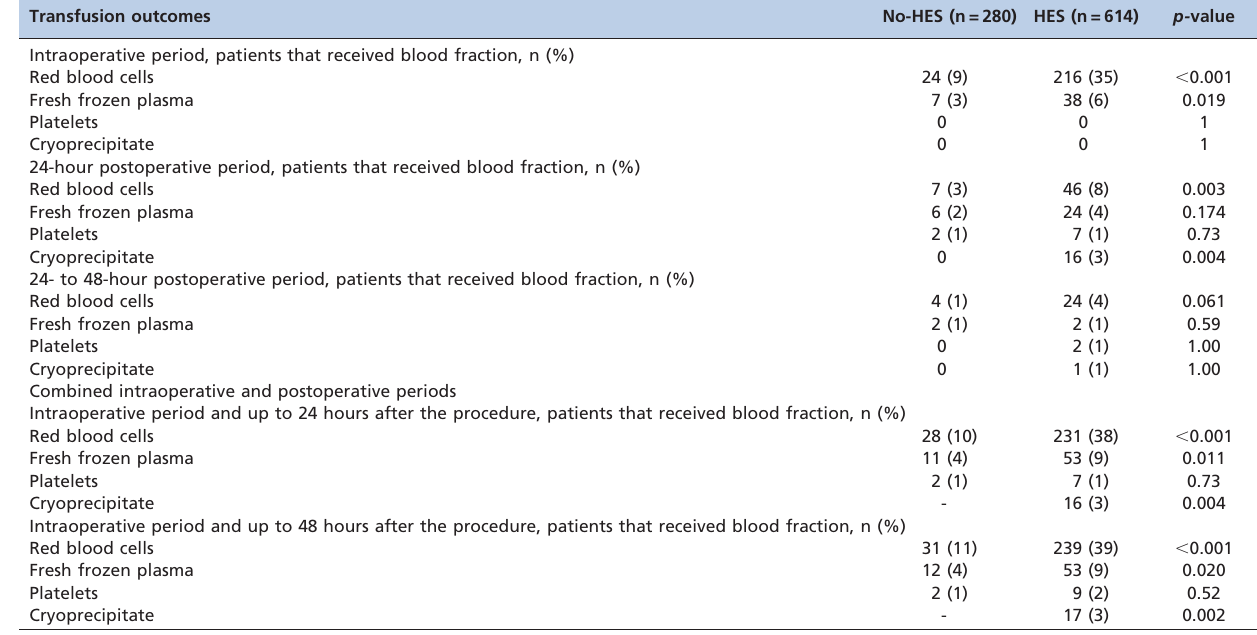
Additional Table 4 - Transfusion outcomes according to standard univariate analysis. Transfusion outcomes